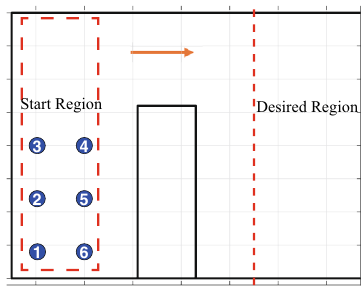
Fig. 6 Schematic diagram of the flight area and initial positions of drones.Thesixdronesareplacedintheflightareaandtheinitialposition of the informed agent can be selected by one of the six positions